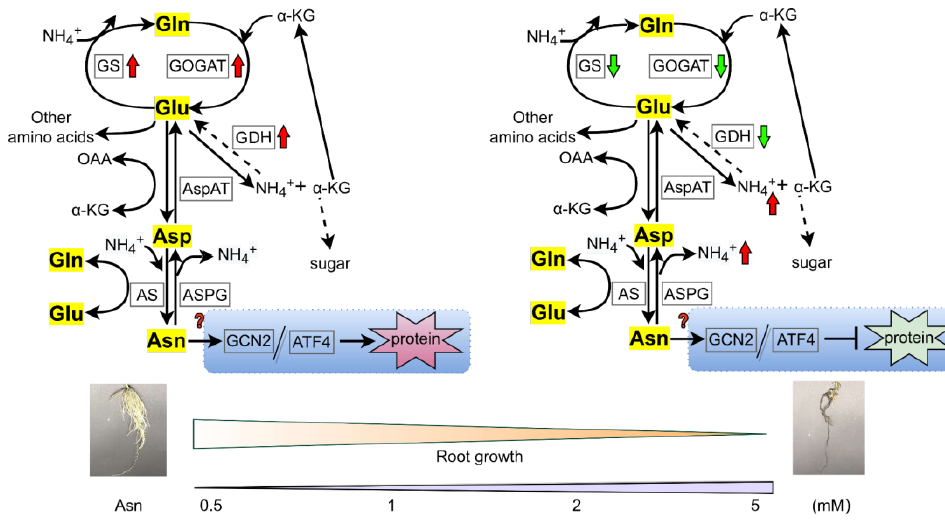
Figure 8. Schematic model of Asn dose-dependent effects on poplar roots. Gln, glutamine; Glu, glutamic acid; Asp, aspartic acid; α -KG, α -ketoglutarate. GS, glutamine synthase; GOGAT, glutamate synthase; AS, asparagine synthetase; ASPG, asparaginase; GDH, glutamate dehydrogenase; AspAT, aspartate aminotransferase; GCN, general control nonderepressible; ATF, activating transcription factor. The up arrow indicates induction and the down arrow indicates depression. The box stands for the enzyme.